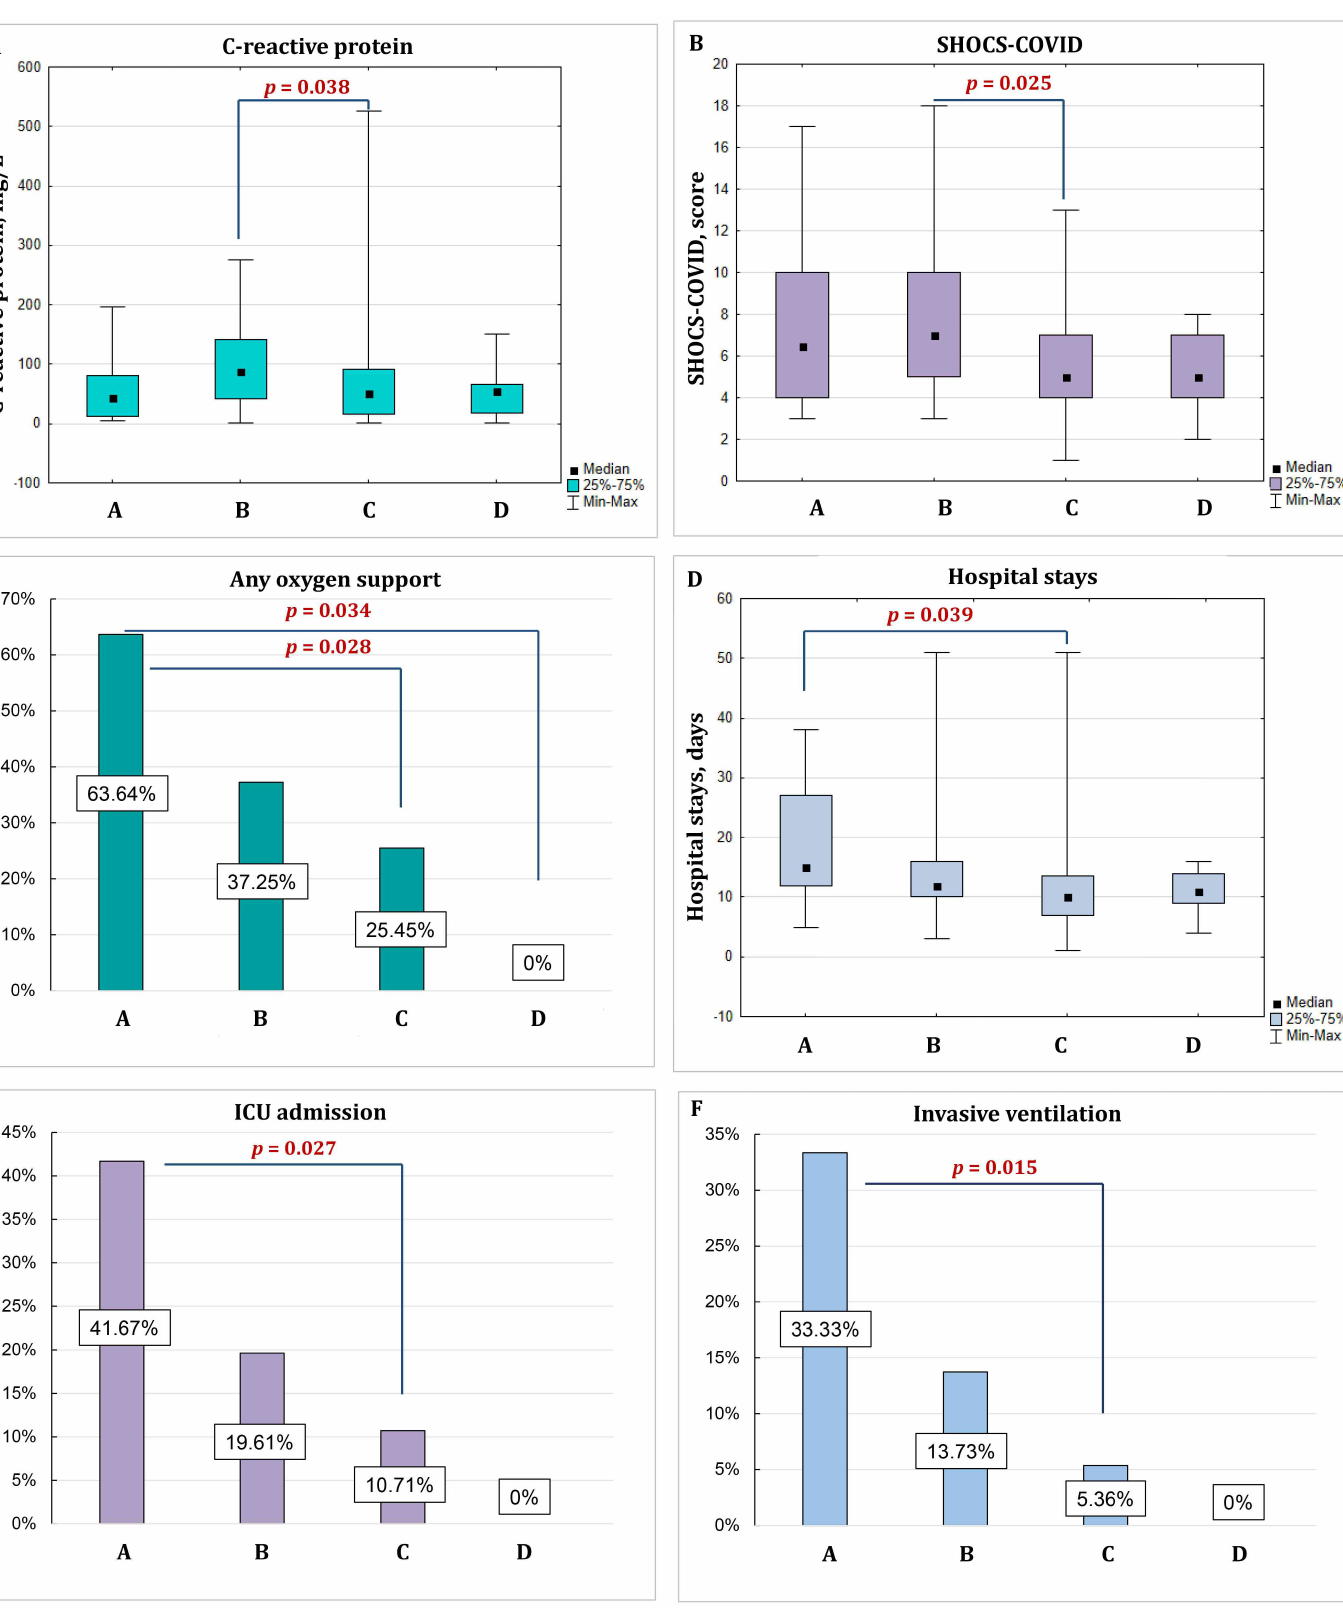
FIGURE 2. Paired comparison of most important data between four groups depending on androgenic status. (A)—CRP depending on androgenic status. (B)—SHOCS-COVID depending on androgenic status. (C)—any oxygen support depending on androgenic status. (D)—hospital stay depending on androgenic status. (E)—ICU admission depending on androgenic status. (F)—invasive ventilation depending on androgenic status. SHOCS-COVID, Symptomatic Hospital and Outpatient Clinical Scale for COVID-19; ICU, intensive care